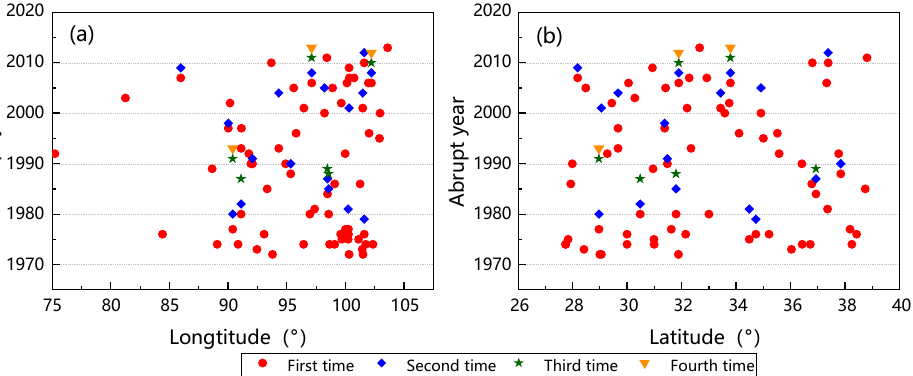
Figure 8. The relationship between the Epan mutation time and the longitude ( a ) and latitude ( b ) for each site on the TP.